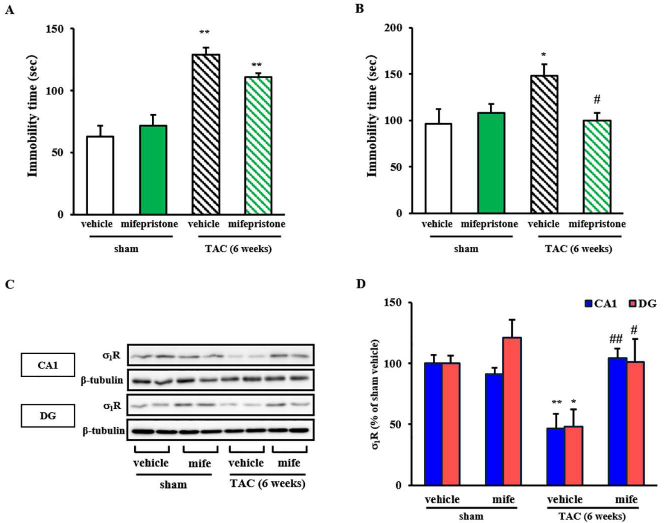
Fig 5. Effect of mifepristone on depressive-like behaviors and hippocampal σ 1 R expression in TAC mice. A: Immobility time in a forced swimming test was measured 6 weeks after TAC surgery with or without drug treatment for the last 4 weeks. F (3, 17) = 13.973, P < 0.01. B: Immobility time in a tail suspension test was similarly measured. Sham and TAC mice were treated with vehicle or mifepristone (mife) (50mg/kg) as indicated(n = 4–7). F (3, 14) = 3.490, P < 0.05. Columns represent means ± S.E.M. * , P < 0.05 and ** , P < 0.01 versus the sham/vehicle group; #, P < 0.05 versus TAC/vehicle treated group. C: Western blot analysis of σ 1 R and β -tubulin (as a loadingcontrol) proteins in the CA1 region and dentate gyrus (DG) of sham and TAC mice treated with vehicle or mifepristone.Immunoblotting with anti- β -tubulin antibody indicatesequal protein loading.D: Densitometric quantification of σ 1 R immunoreactivity (n = 4). Columns represent means ± S.E.M. F (3, 16) = 9.009, P < 0.01 (CA1); F (3, 20) = 4.885, P < 0.05. * , P < 0.05 and ** , P < 0.01 versus sham/vehicle- treated mice. #, P < 0.05 and ##, P < 0.01 versus the TAC/vehicle-treated